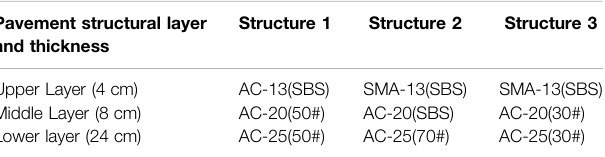
TABLE 1 | Structural combination and asphalt layer thickness of semi-rigid base asphalt